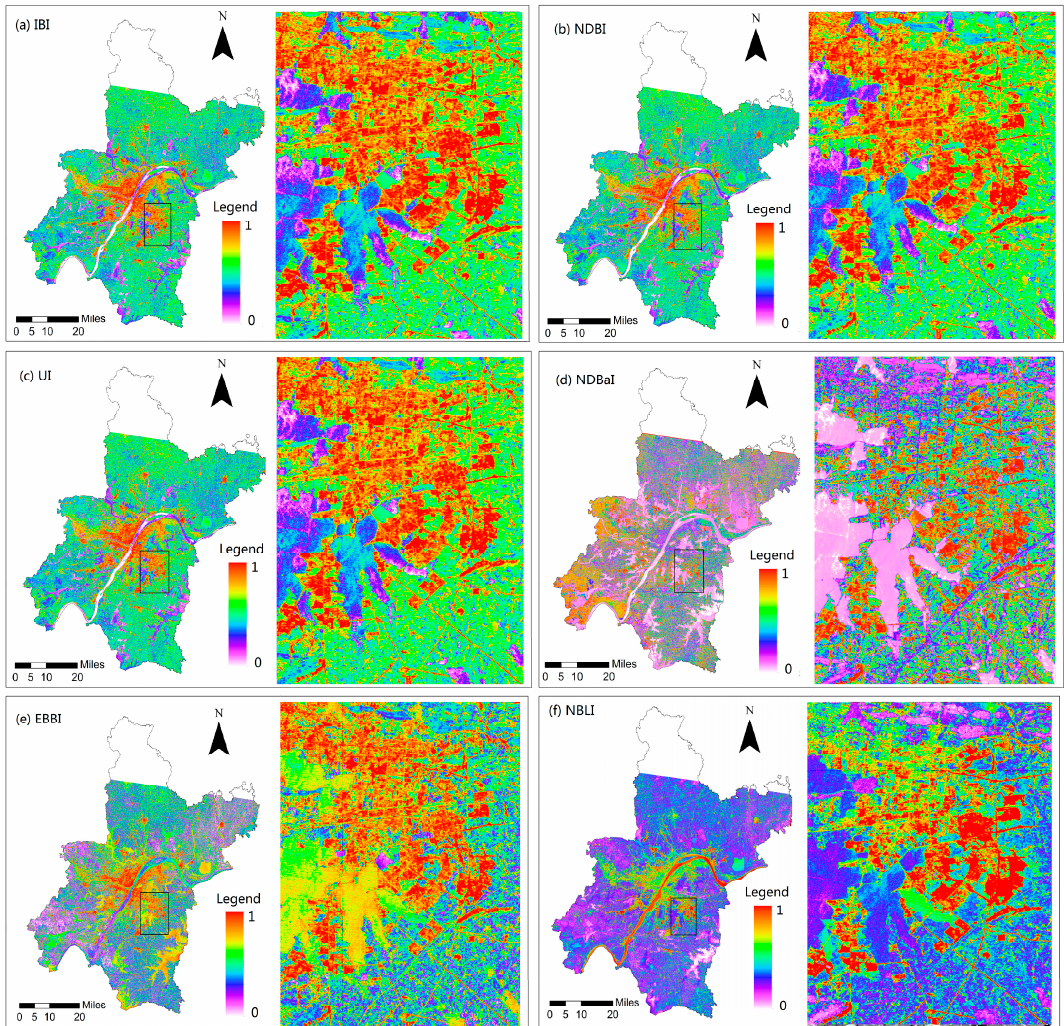
Figure 6. Index images in color: ( a ) IBI; ( b ) NDBI; ( c ) UI; ( d ) NDBaI; ( e ) EBBI; and ( f ) NBLI. The right panel in each image shows the details of the subset area (the black box in the left panel).